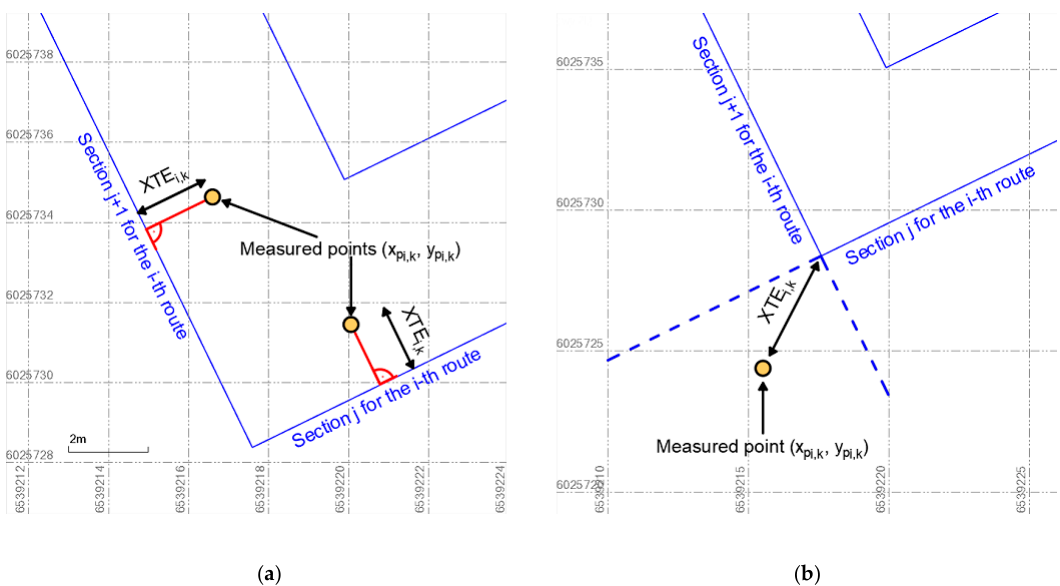
Figure 9. A graphical method for determining the distance of the measured point to the designed route, if the straight lines perpendicular to the hydrographic profiles could be drawn ( a ) and it is not possible to determine the perpendicular line ( b ).